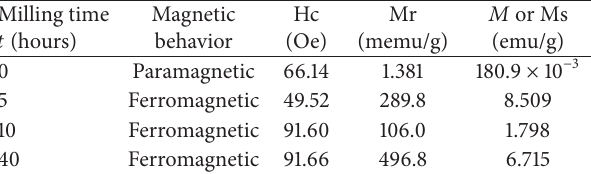
Table 2: Magnetic parameters obtained from VSM measurements.